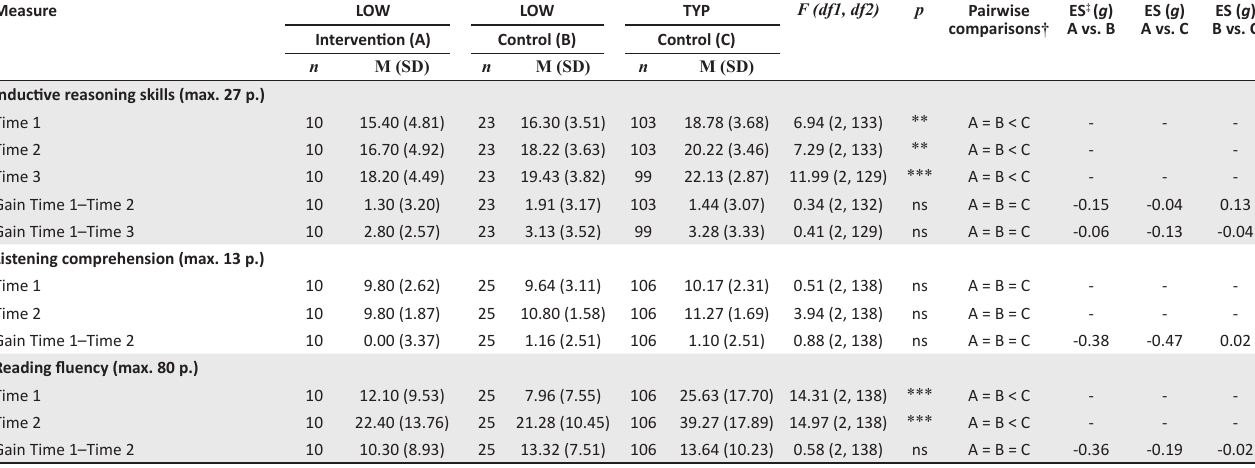
ES ‡ ( g ) ES ( g ) ES ( g ) comparisons † A vs. B A vs. C B vs. C